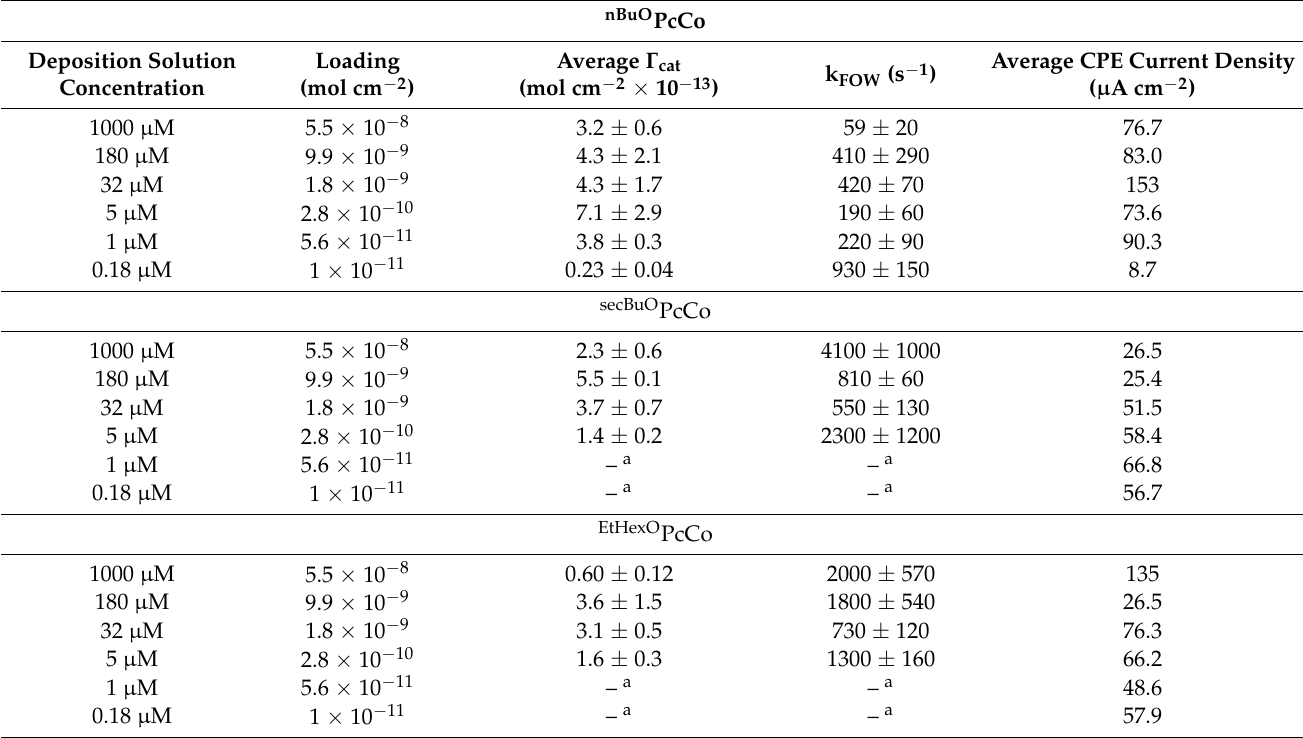
Table 2. Summary of electrochemical data for RO CoPc complexes.